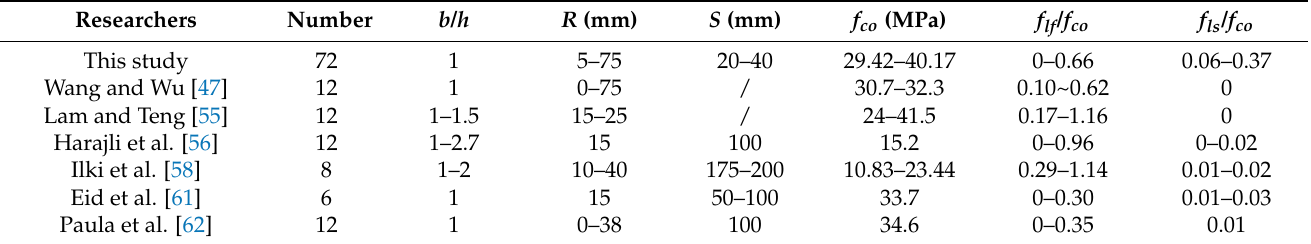
Table 3. Constraint efficiency of constrained rectangular concrete column